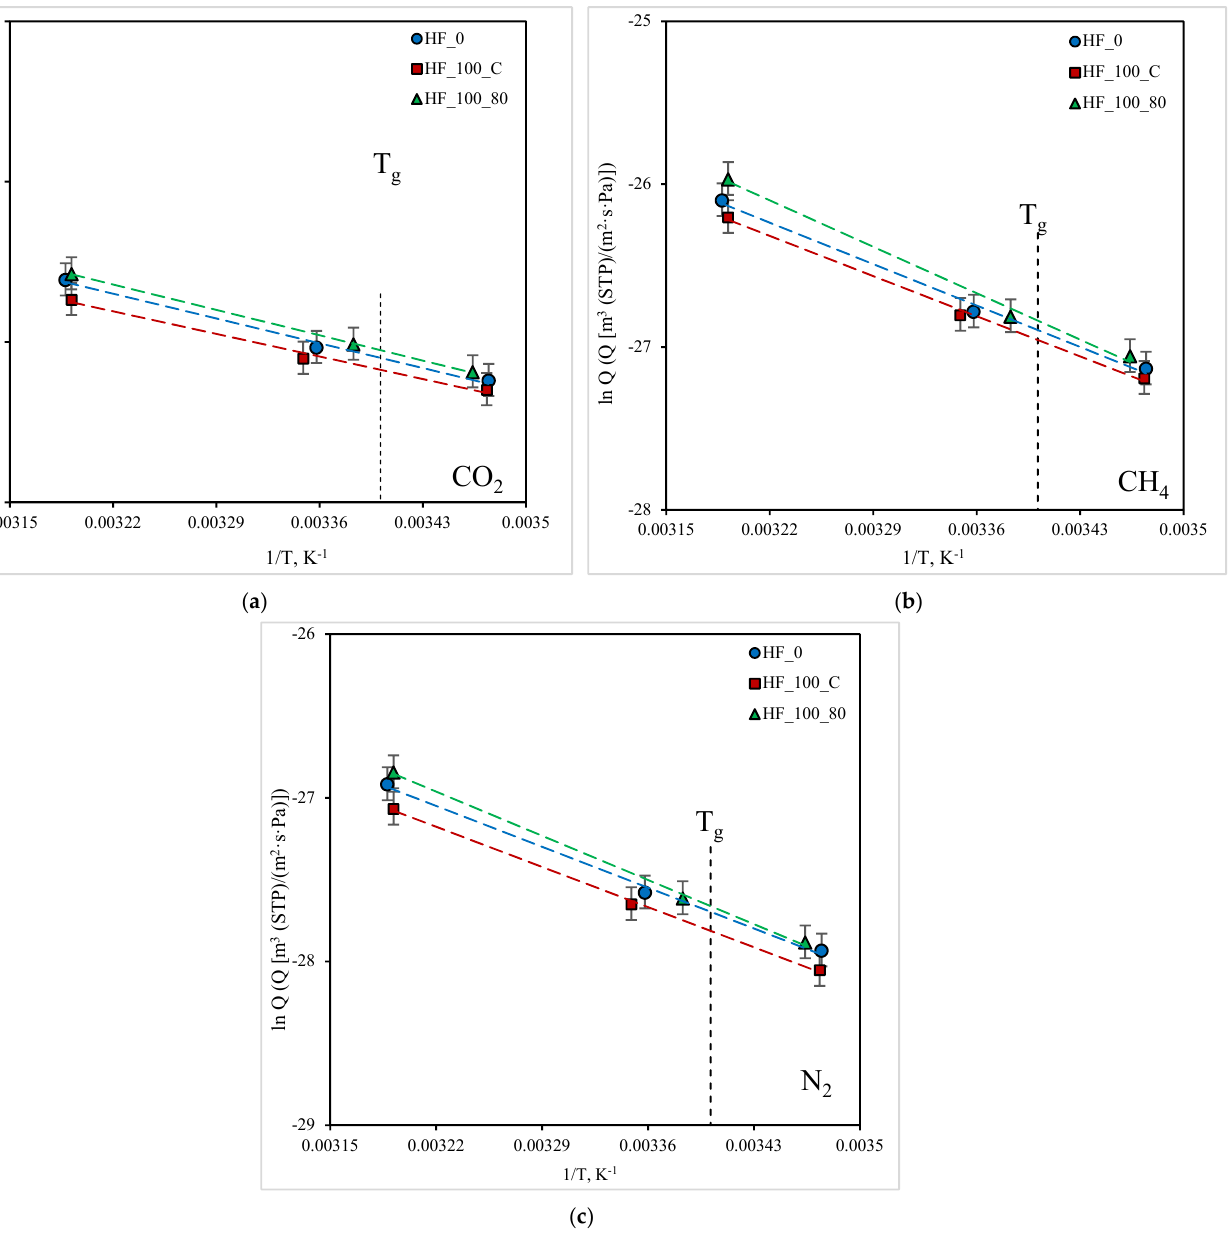
Figure 8. Dependence of CO 2 , CH 4 , and N 2 permeance on temperature in Arrhenius coordinates for the studied HF samples: ( a ) CO 2 ; ( b ) CH 4 ; ( c ) N 2 . Obtained data array represents new results of gas mixture transport in PMP for the Table 8. Apparent activation energies of permeability E p for CO 2 , CH 4 , and N 2 in PMP specified temperature range. It is shown that temperature dependences are linear in Ar- rhenius coordinates and there are no visible deviations from linearity at the transition across T g of the polymer, i.e., the permeability for the gases is insensitive towards T g . There is a tendency to an increase in permeability with an increase in temperature for all studied gases. To make it possible to predict the transport and separation characteristics of the HFs and membrane modules based on them in a wide temperature range, the apparent activation energies of the permeability E p of the studied gases for HFs samples was deter- mined using an approximation of experimental dependences by Equation (4). The ob- tained values are presented in Table 8.